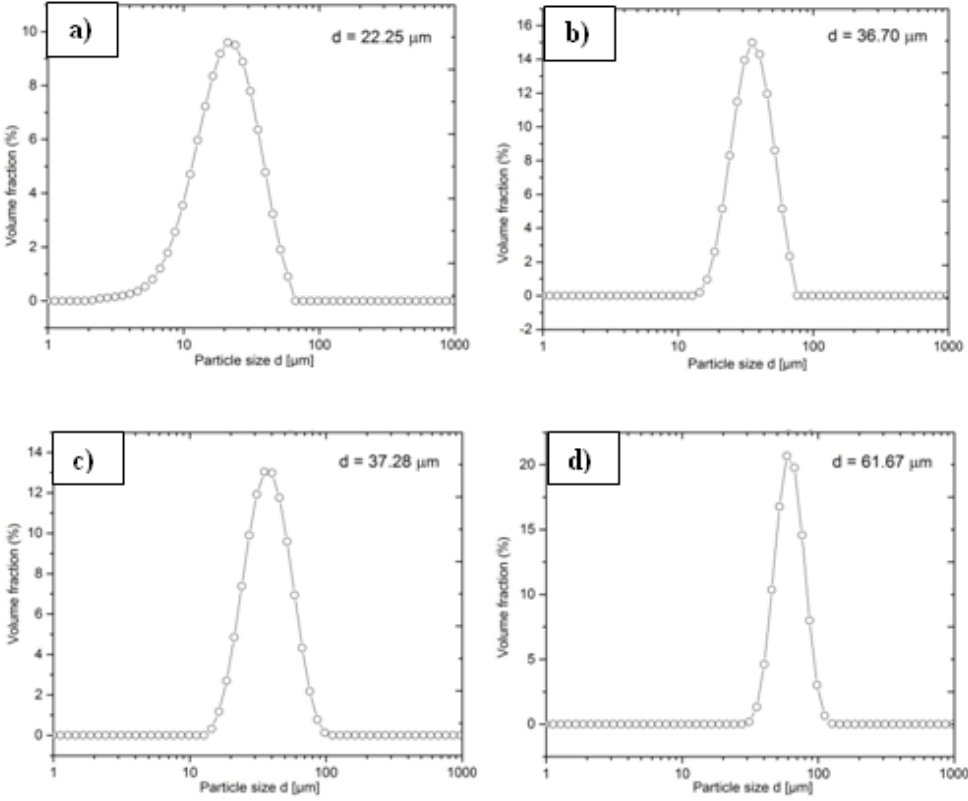
Figure 3. Grain size distribution of nickel powders: ( a ) C30 , ( b ) M28 , ( c ) A34 , and ( d ) O60 .